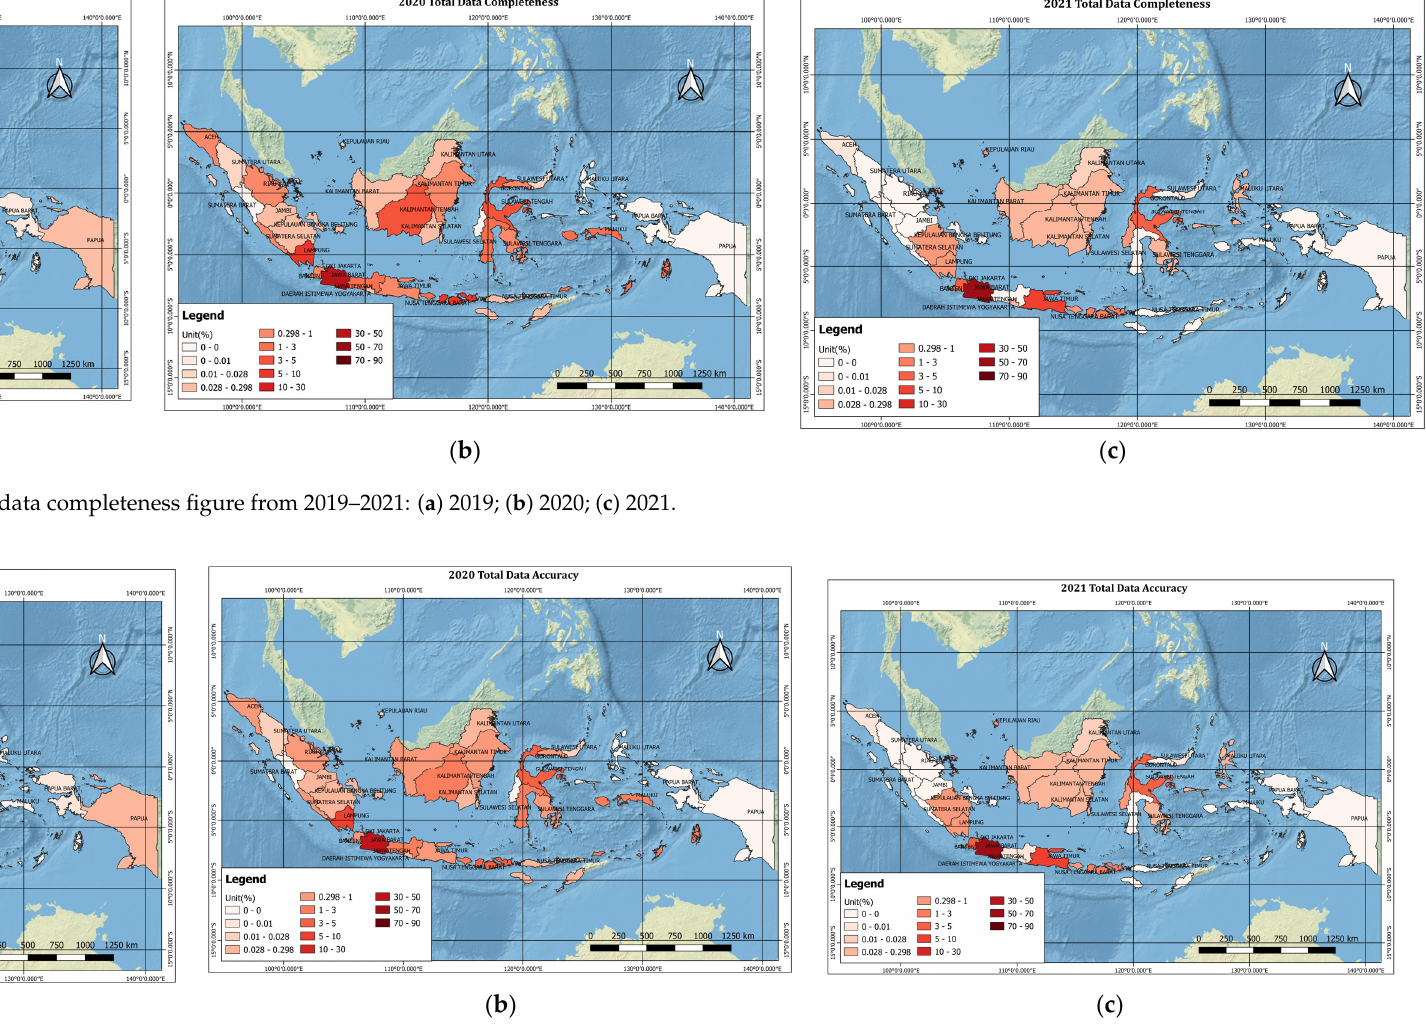
( c ) Figure 3. Data consistency figure from 2019–2021: ( a ) 2019; ( b ) 2020; ( c ) 2021.